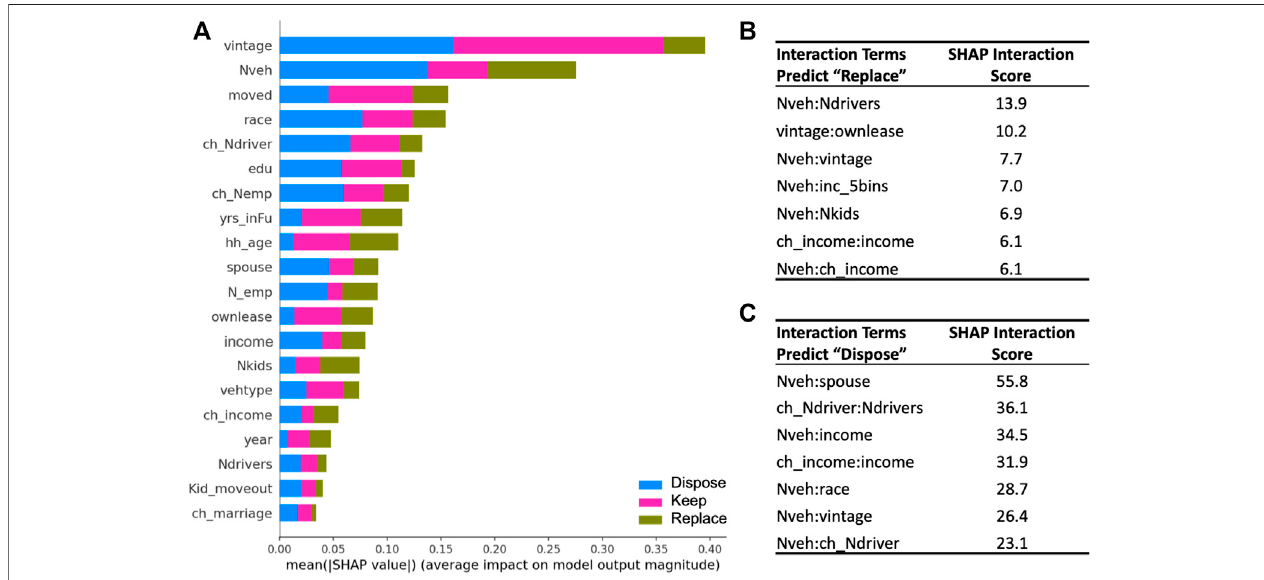
FIGURE 5 | (A) SHAP Feature Importance considering all three outcomes; and interaction term scores for predicting “ replaced ” (B) , and (C) “ disposed ” .